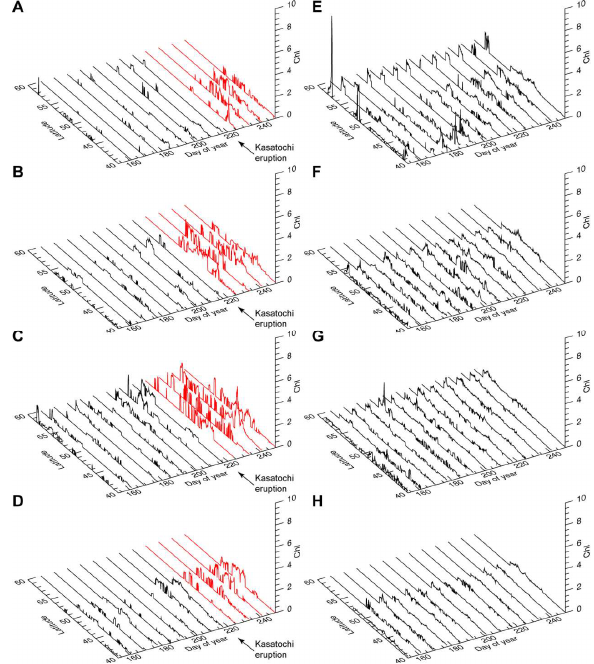
Fig. 5. MODIS Aqua 8-day composites of Chl- a along N-S tran- Figure 5. MODIS Aqua 8-day composites of Chl-a along N-S transects at 175° W 3 sects at 175 ◦ W ( A and E ), 165 ◦ W ( B and F ), 155 ◦ W ( C and G ) and 145 ◦ W ( D and H ) from 60 ◦ N to 40 ◦ N for 2008 (left column: (A and E), 165° W (B and F), 155° W (C and G) and 145° W (D and H) from 60° N 4 A, B, C, D) and the mean values from 2002 to 2007 (right column: to 40° N for 2008 (left column: A, B, C, D) and the mean values from 2002 to 2007 5 E, F, G, (right column: E, F, G, H). 6